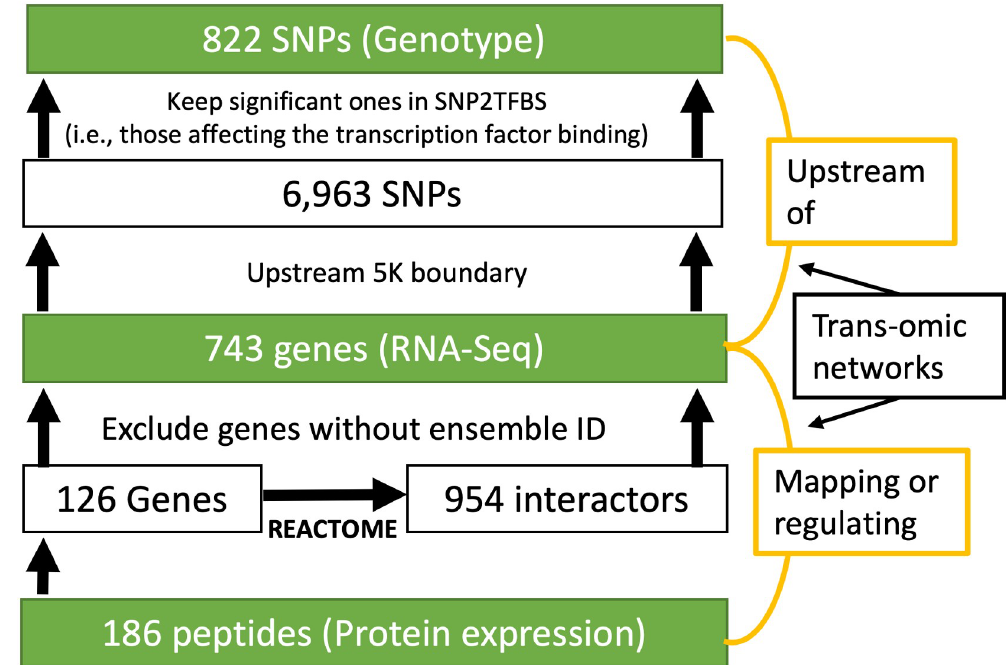
Fig 1. The selection of SNPs in upstream 5K boundary for each